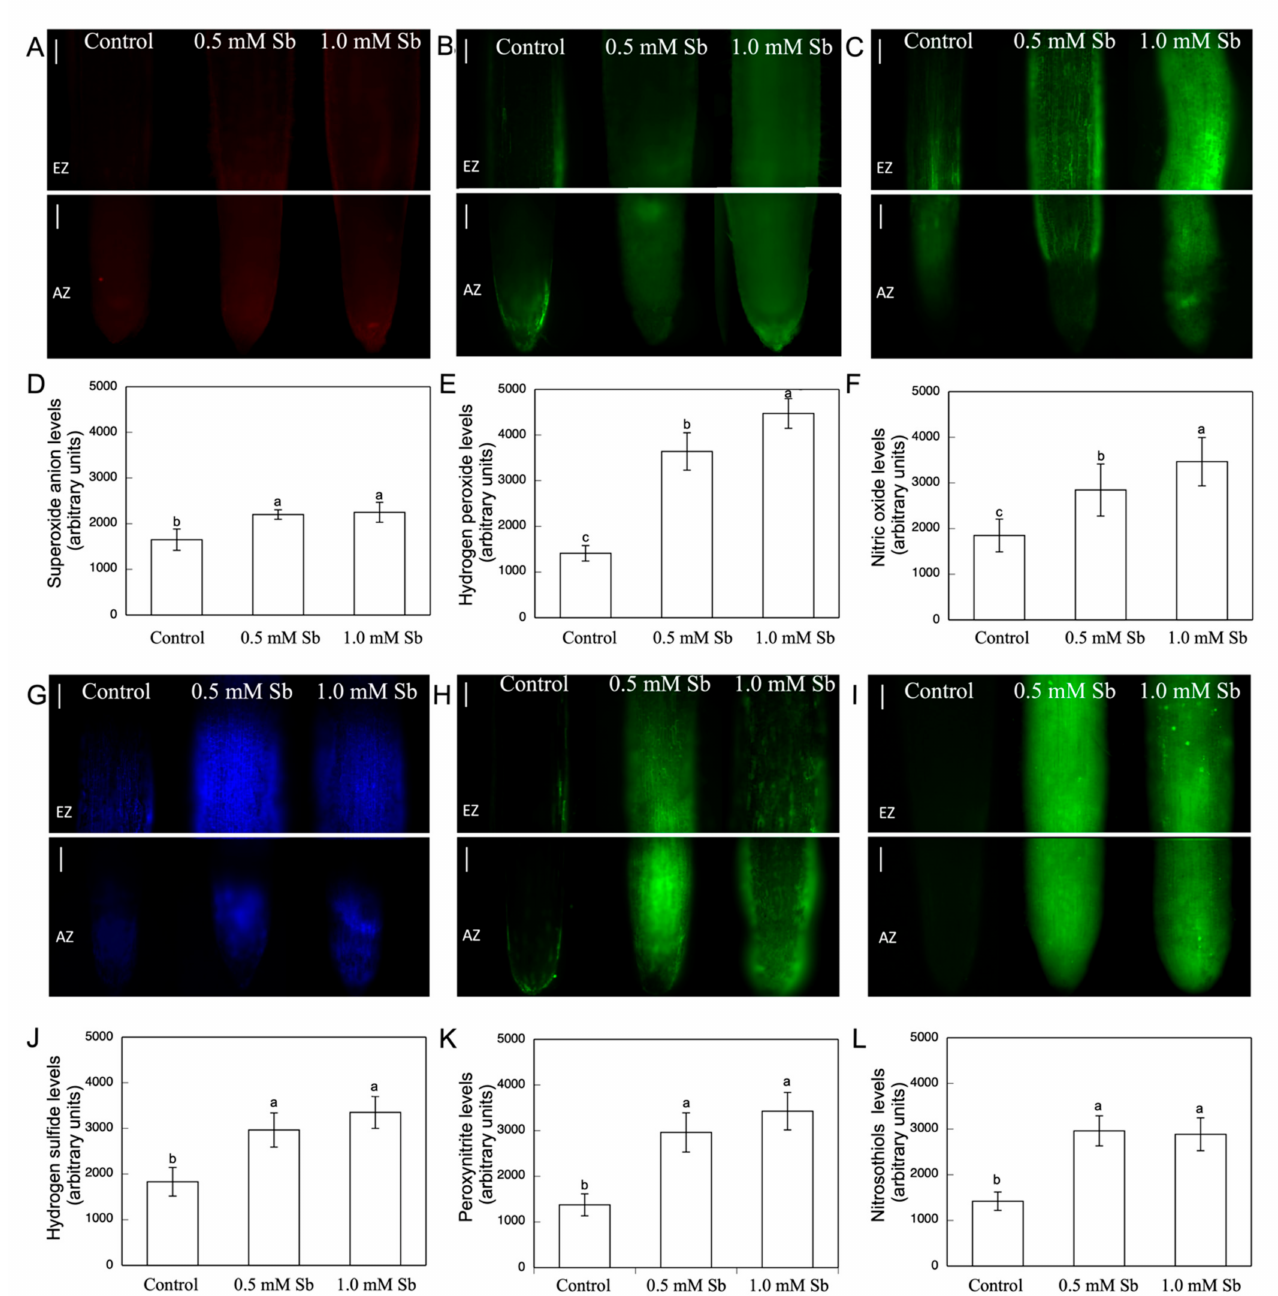
Figure 3. Detection of superoxide anion, hydrogen peroxide, nitric oxide, hydrogen sulfide, peroxynitrite, and S-nitrosothiols in the roots ( A – C , G – I ), and the average fluorescence intensity levels quantified in arbitrary units ( D – F , J – L ), respectively. At least five roots were tested for each experimental condition and five independent repeats were analysed (different letters indicate significant differences at p < 0.05, Mann–Whitney U-test). Bar: 200 µ m. The Sb toxicity caused a significant increase in H 2 O 2 content in roots, by 82% and 346%, and leaves, by 100% and 153%, for 0.5 mM and 1.0 mM Sb, respectively (Figure 2C). With respect to the amount of accumulated H 2 O 2 determined by fluorescence